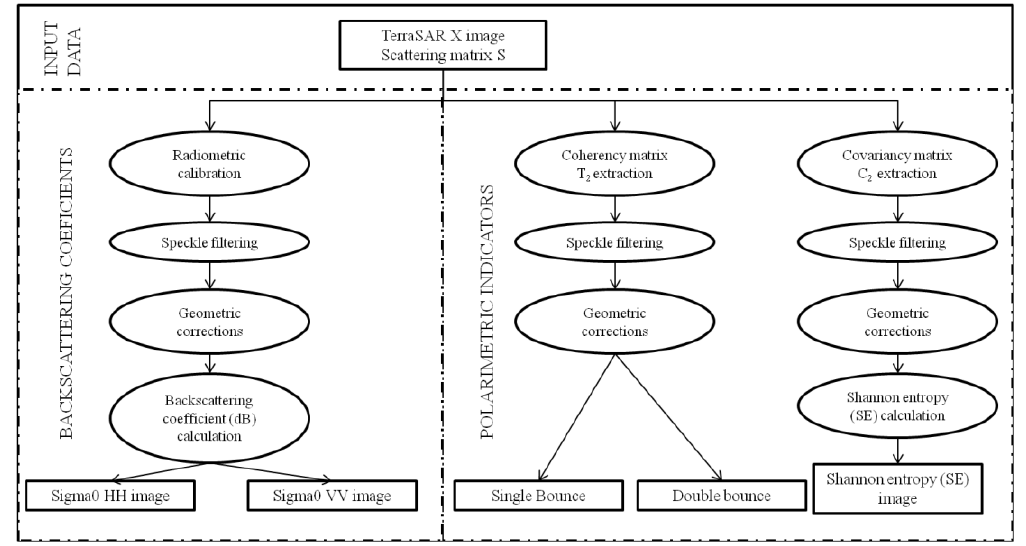
Figure 4. Workflow of the radar data